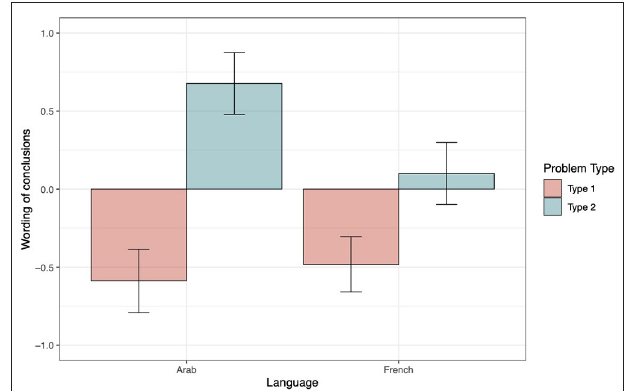
FIGURE 2 | Wording of conclusions as a function of Problem type and Language. A negative score indicates a higher proportion of “left” conclusions (coded as − 1), and a positive score, a higher proportion of “right” conclusions (coded as + 1). The within-subjects 95% confidence intervals were computed following the method proposed by Morey (2008) and were implemented using the R functions developed by Chang (2018). an RTL scanning, Yemeni showed a clear preference for “right” (84%) over “left” conclusions (16%), whereas French produced as many “left” as “right” conclusions (45 vs.